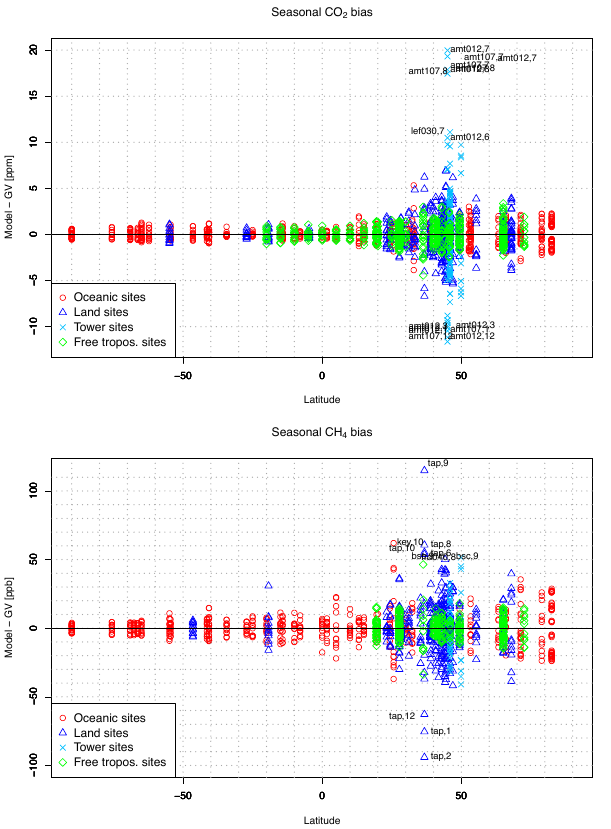
Fig. 4. Same as Fig. 3, but for monthly biases for CO 2 (top) and CH 4 (bottom). Letters and numbers in the plot represent GV site code and month, respectively.